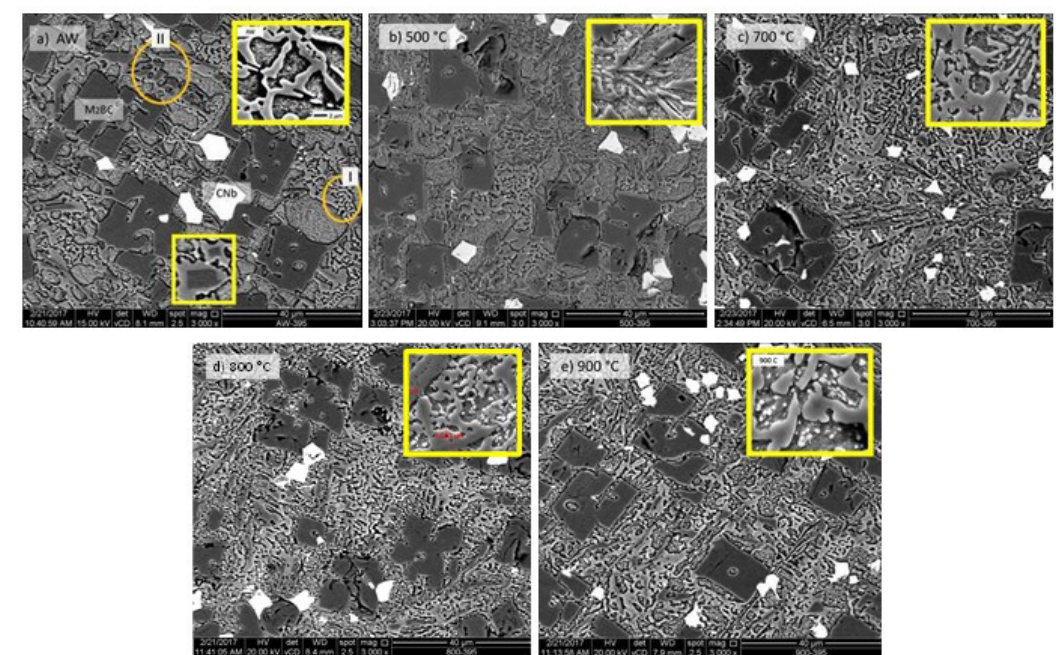
Figure 3. BSD images of the test specimen a) AW, b) 500, c) 700, d) 800 and e) 900 °C.